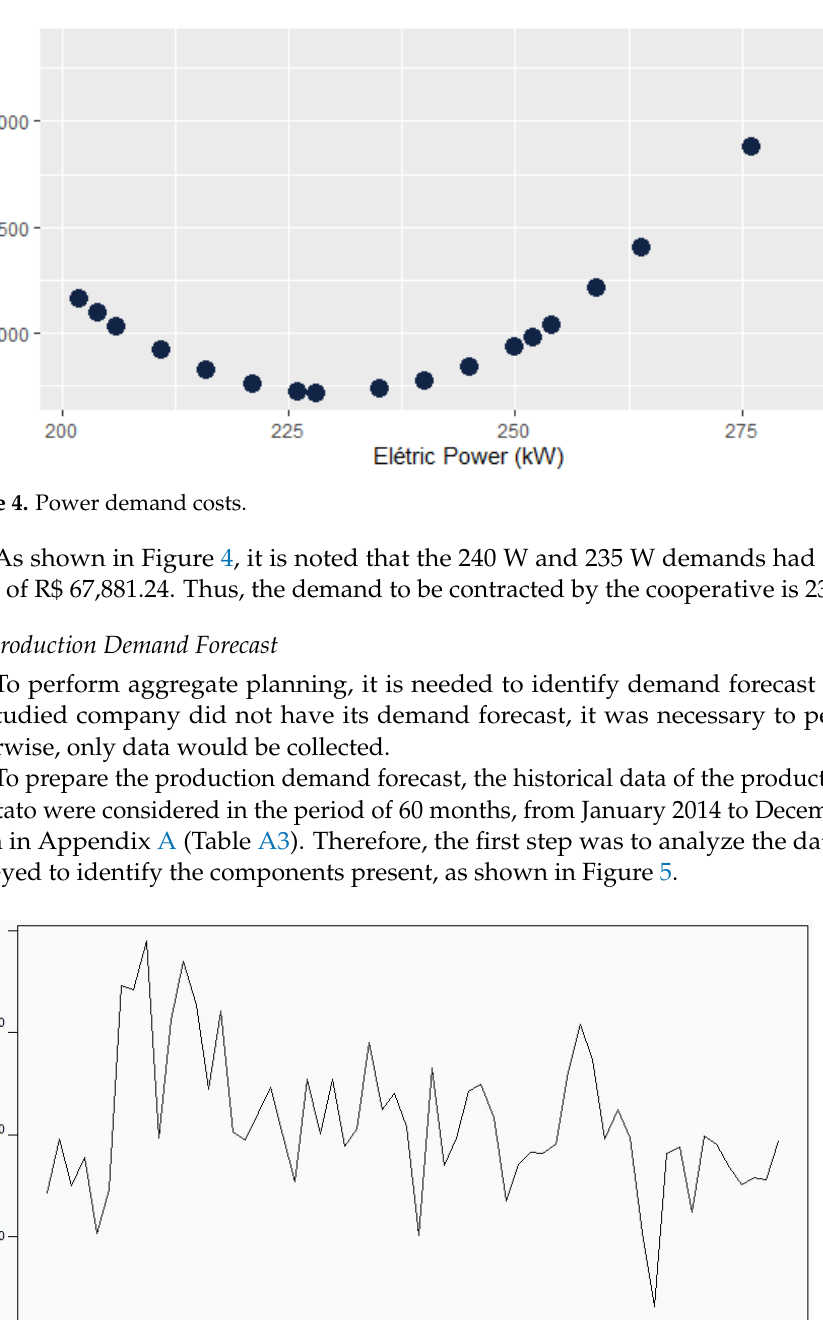
Figure 4. Power demand costs.